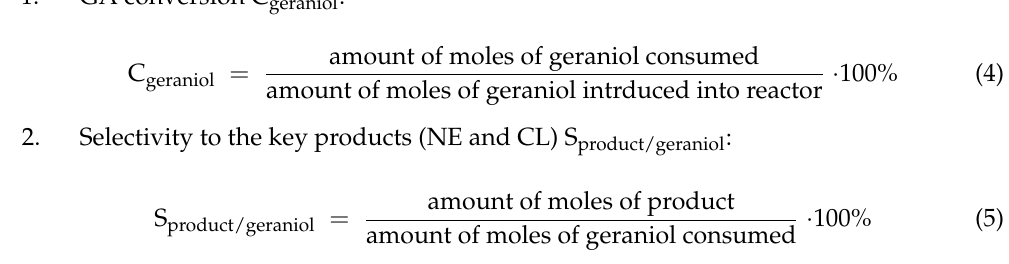
Figure 10. Details of garnet grains: ( a ) SEM view, ( b ) optical microscope view.